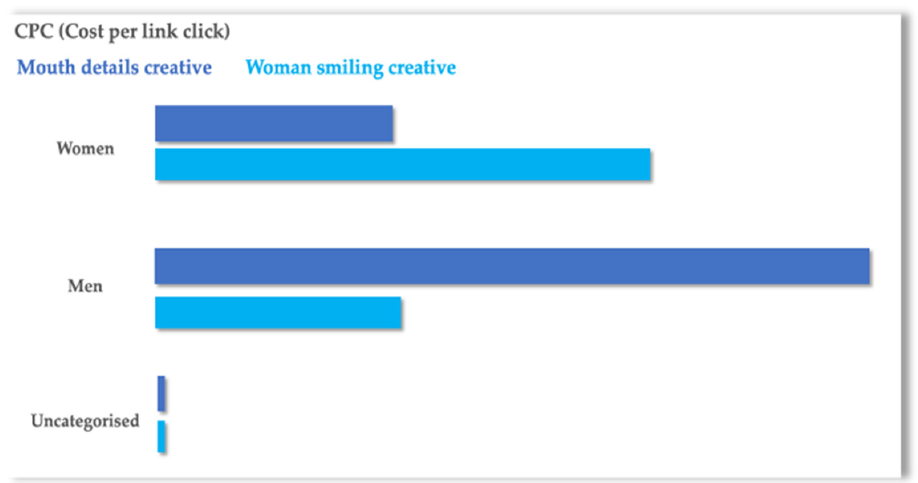
Figure 5. The cost per 1000 people reached by gender.